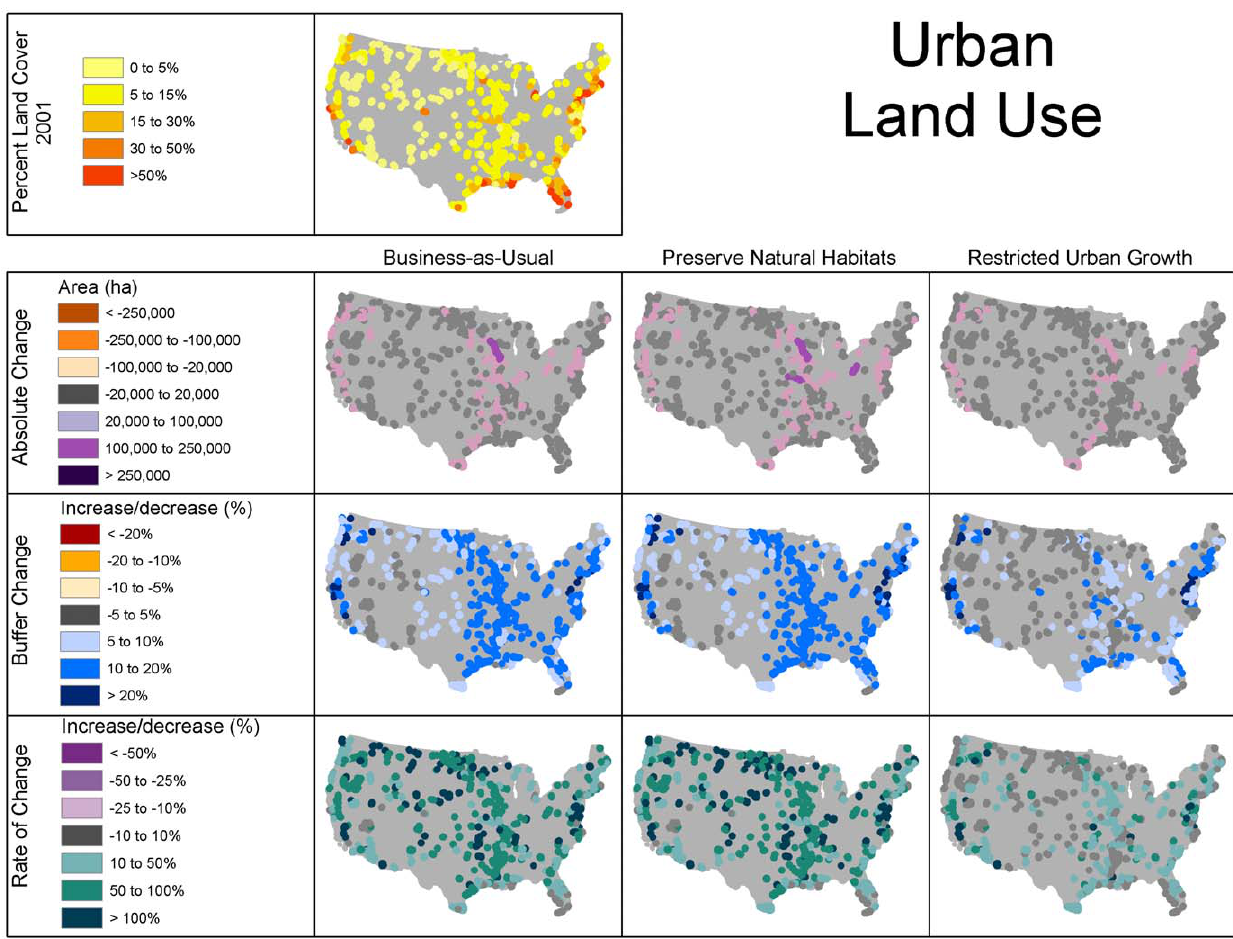
Figure 5. Initial land use and change in urban land use under the different scenarios.